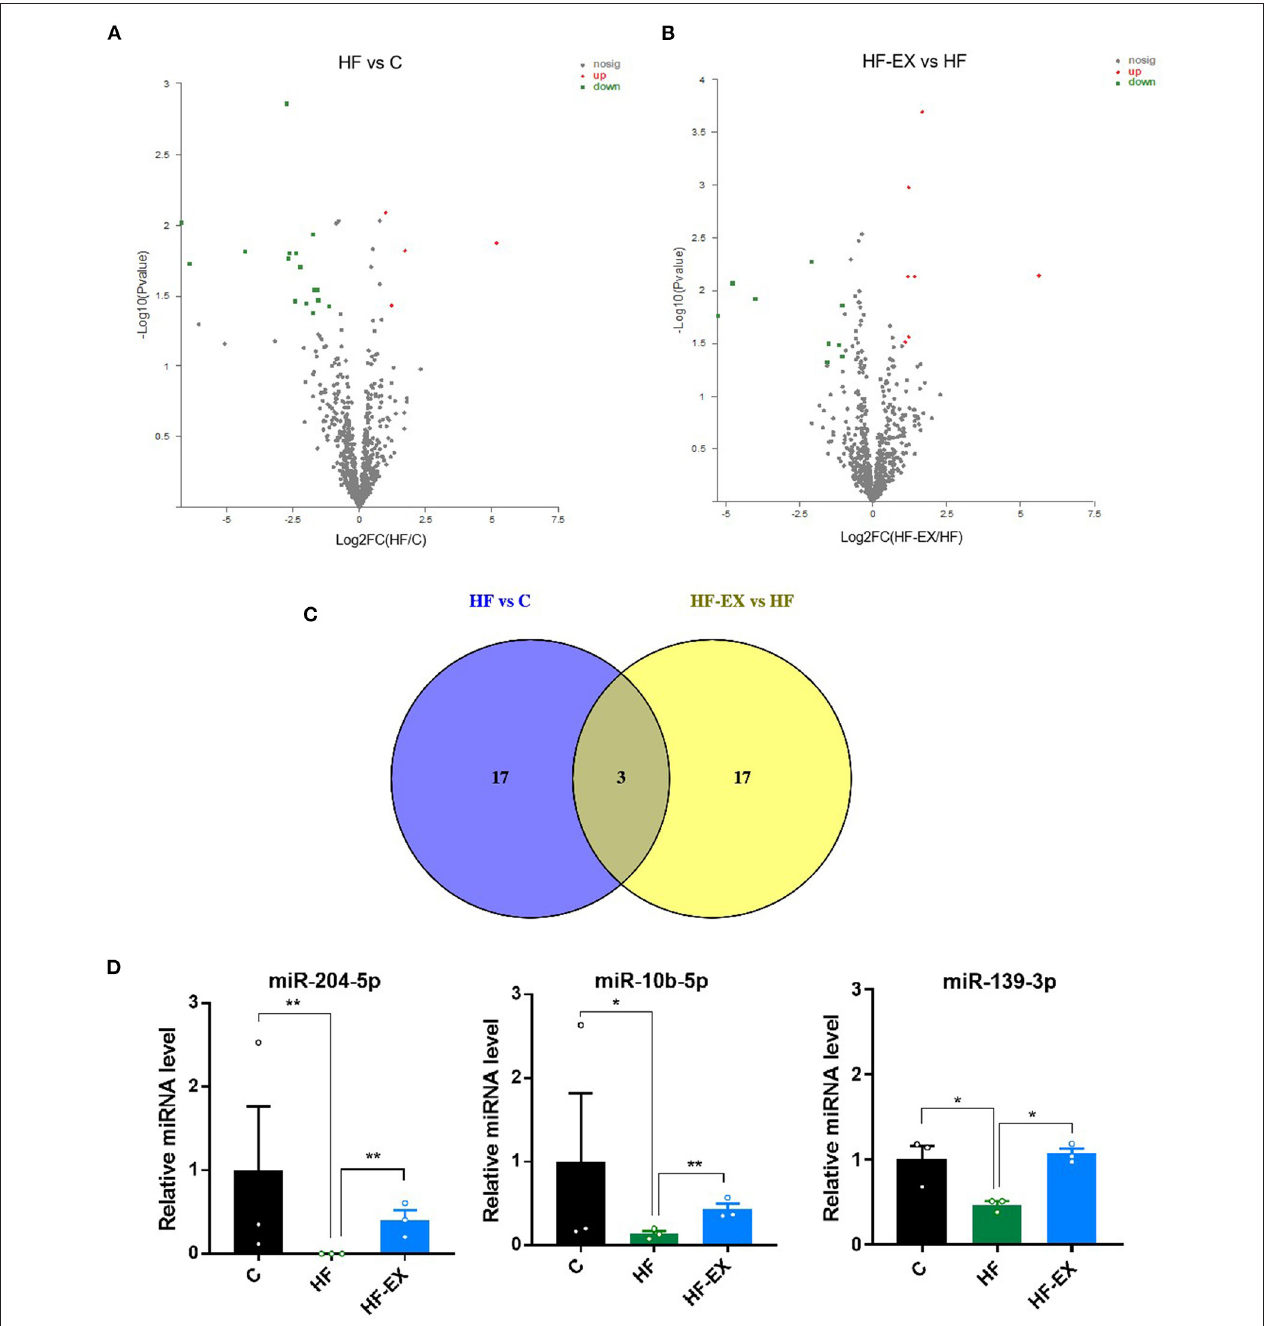
FIGURE 5 | Maternal HFD and exercise regulated hepatic miRNA expression in adult offspring. (A) Volcano plot of miRNAs between HF and C groups; (B) volcano plot of miRNAs between HF-EX and HF groups; (C) Venn diagram of the differentially expressed miRNAs among the three groups; (D) lists of the three differentially expressed miRNAs. C, offspring of dams fed the normal control diet; HF, offspring of dams fed the high-fat diet; HF-EX, offspring of dams intervened with a high-fat diet and exercise; HFD, high-fat diet. Data are expressed as means ± SD ( n = 3 / group). Mean values were significantly different between the groups: * p < 0.05, ** p <